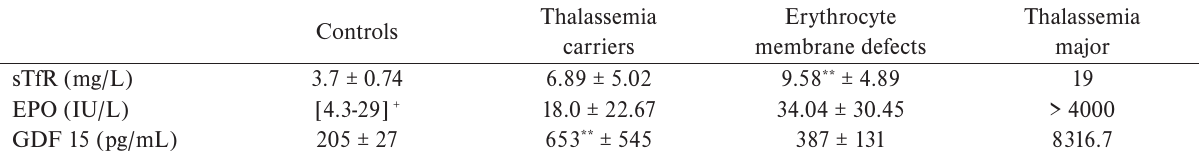
Table 2. Parameters of erythropoietic activity.